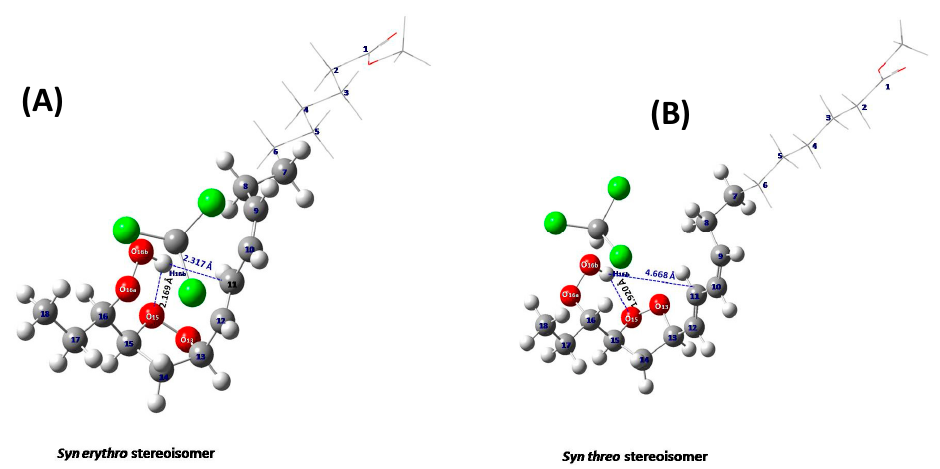
Figure 10. Structural comparison of the full-length syn erythro ( A ) and syn threo ( B ) endo -hydroperoxides, with a discrete solvation molecule of CHCl 3 (energy minimization using the APFD/6-31+G(d):PM6 method).